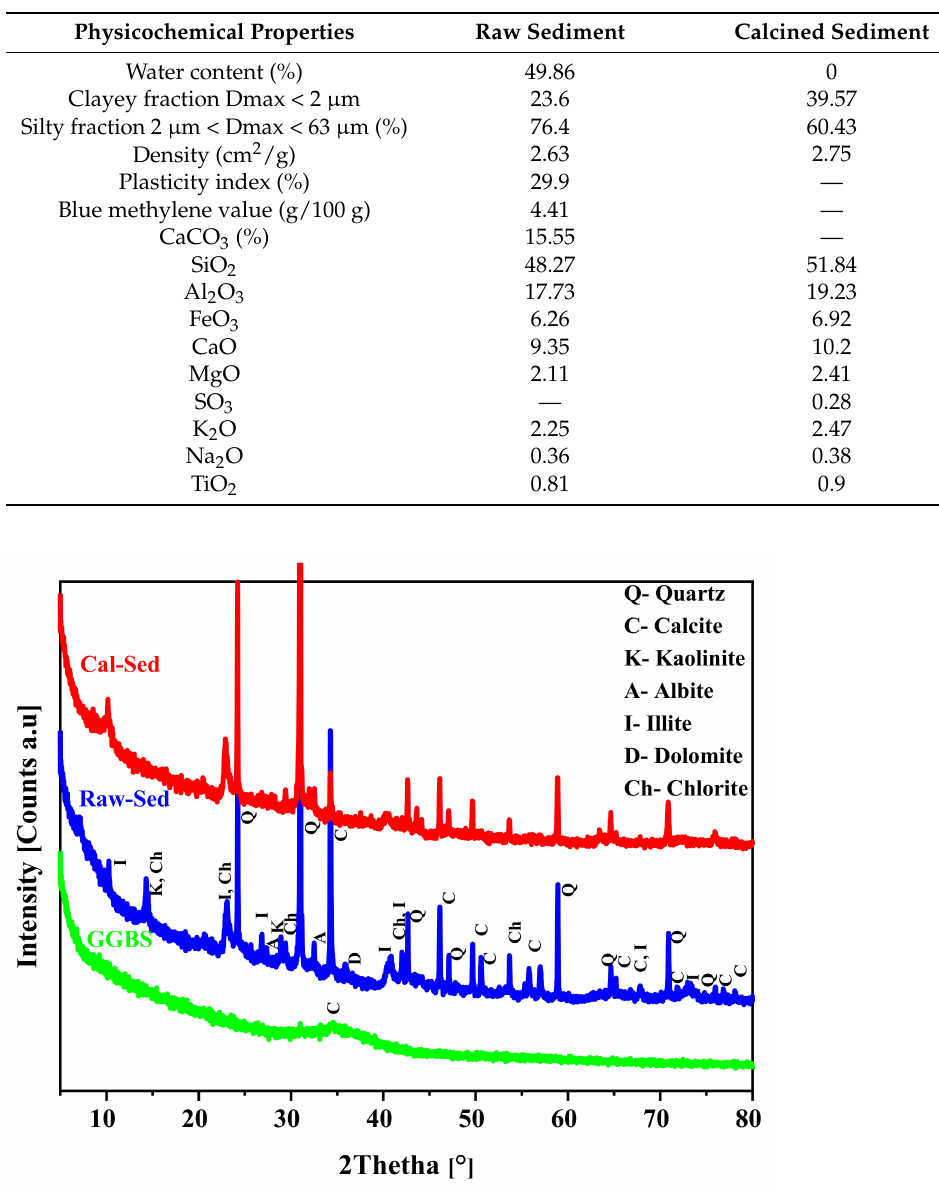
Figure 5. XRD diffraction patterns of GGBS and